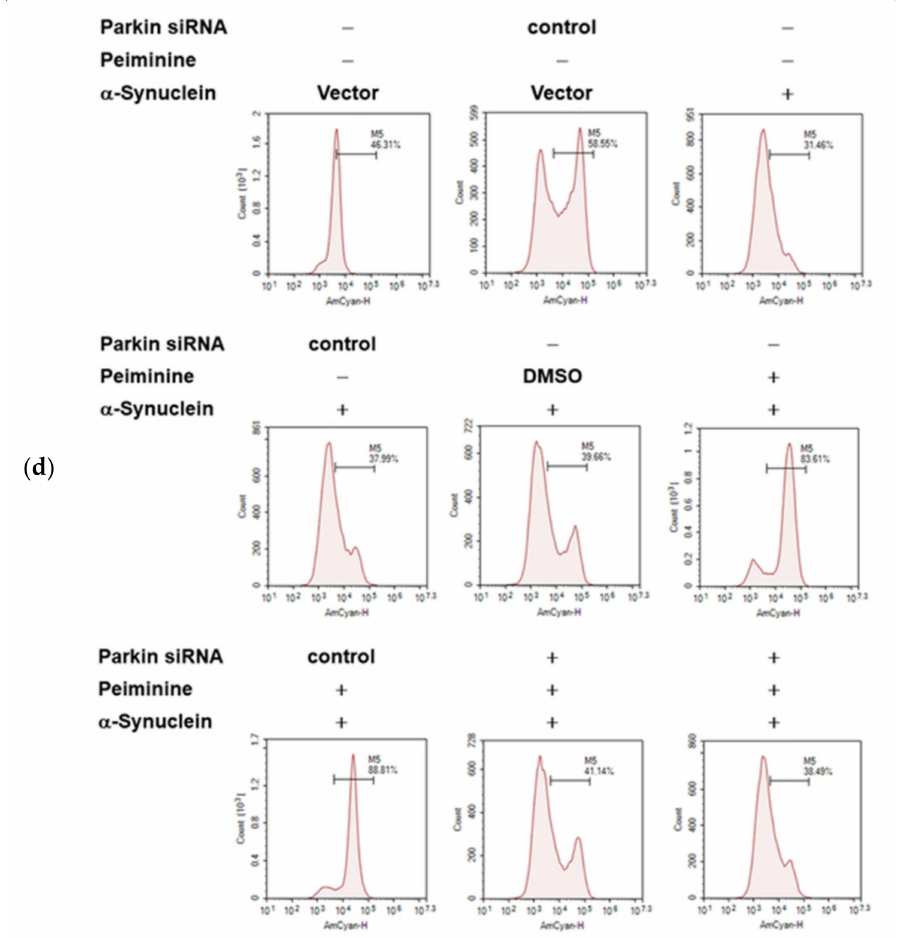
Figure 11. Down-regulation of parkin can abolish the ability of PMN to promote UPS activity and autophagy in α -synuclein-overexpressing SH-SY5Y cells. α -Synuclein-overexpressing SH-SY5Y cells were transfected with control siRNA or parkin siRNA for 24 h. Next, the transfected cells were treated with 1 µ M PMN or untreated for 24 h and then analyzed. ( a ) Suc-Leu-Leu-Val-Tyr-AMC was used as a substrate for measuring proteasome activity. The relative fold of the proteasome activity is represented as the ratio of the activity of each group to the control group. ( b ) Acridine orange staining was used to evaluate the number of acidic vesicular organelles in cells. The representative fluorescence images of each group are shown here. ( c ) The fluorescence intensity of the staining in ( b ) was analyzed by employing ImageJ software. The relative fluorescence intensity is shown as the ratio of the fluorescence intensity of each group to that of the control group. ( d ) Cells were incubated with the Autophagosome Detection Reagent for 30 min and analyzed by flow cytometry. The results shown above are the standard errors of the average of three independent experiments. # Indicates a significant difference between the α -synuclein-overexpressing group and the control group ( ## p < 0.01, ### p < 0.001). * Indicates a significant difference between the PMN-pretreated group and the PMN-untreated group (** p < 0.01, *** p <